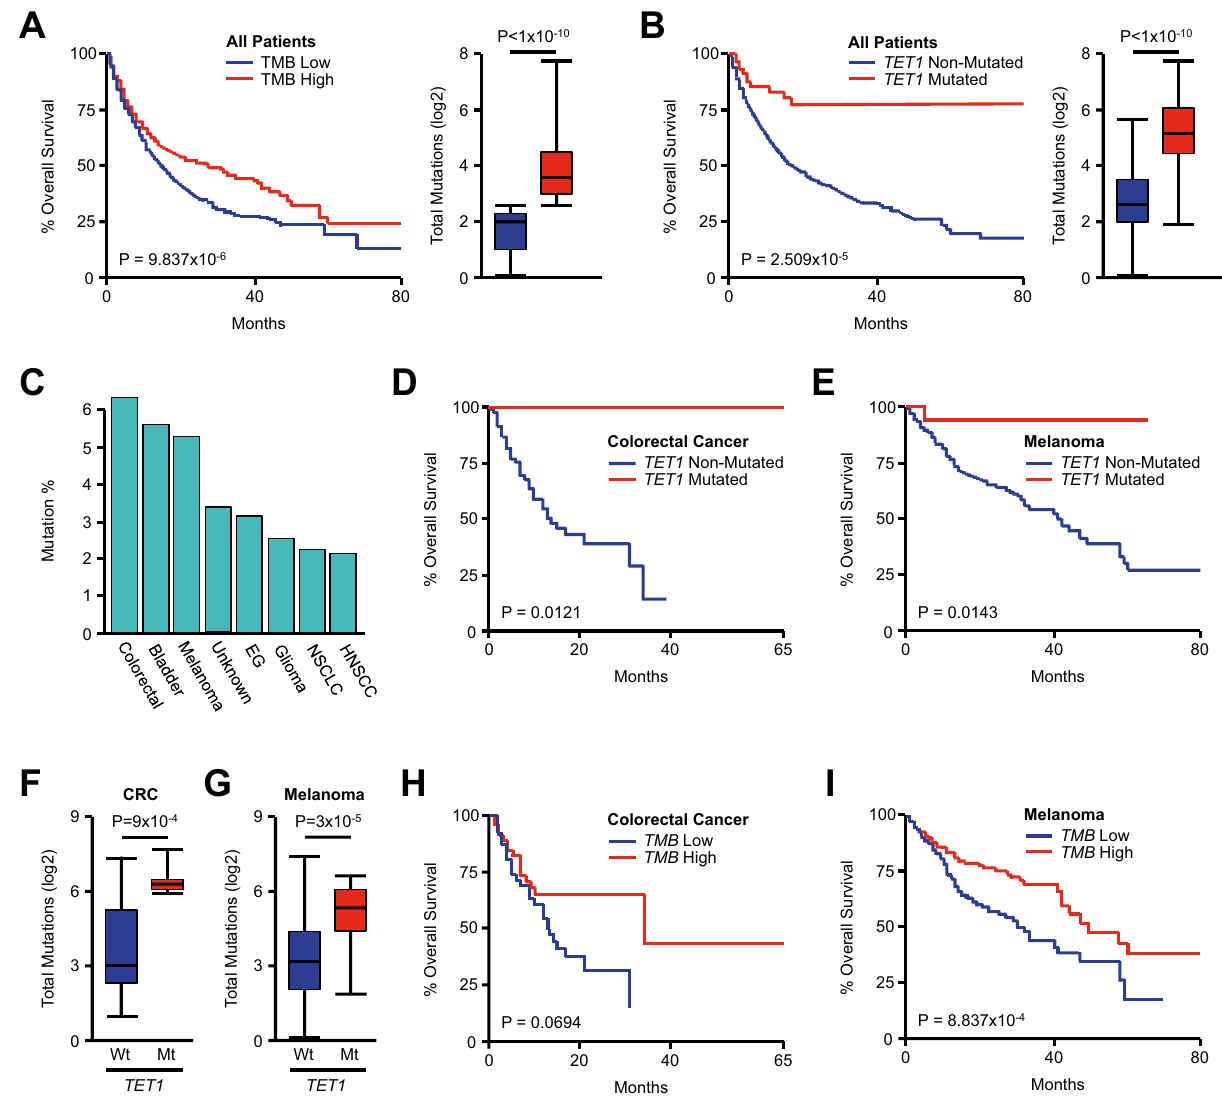
Figure 3. TET1 mutations are associated with improved outcomes in colorectal cancer and melanoma patients receiving immune checkpoint inhibitors. ( A ) Kaplan Meier plot showing overall survival for the pan-cancer cohort (N = 1661) for patients with either a high (above median) or low (below median) tumor mutational burden (TMB). ( B ) Overall survival and the total number of mutations for all patients arranged by TET1 mutation status (58 TET1 -mutated and 1603 TET1 -non-mutated patients) ( C ) The percent of TET1 -mutated patients arranged by tumor type. ( D – G ) Overall survival and the total number of mutations for patients from the colorectal cancer (N = 110, 7 TET1 -mutated and 103 TET1 -non-mutated patients) or melanoma (N = 320, 18 TET1 -mutated and 302 TET1 -non-mutated patients) cohorts arranged by TET1 mutation status. ( H , I ) Overall survival for the colorectal cancer and melanoma cohorts arranged by